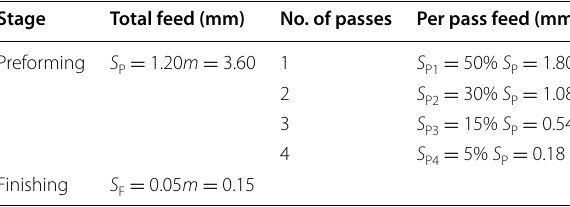
Table 3 Feeding amounts in each preforming pass and finishing stage Stage Total feed